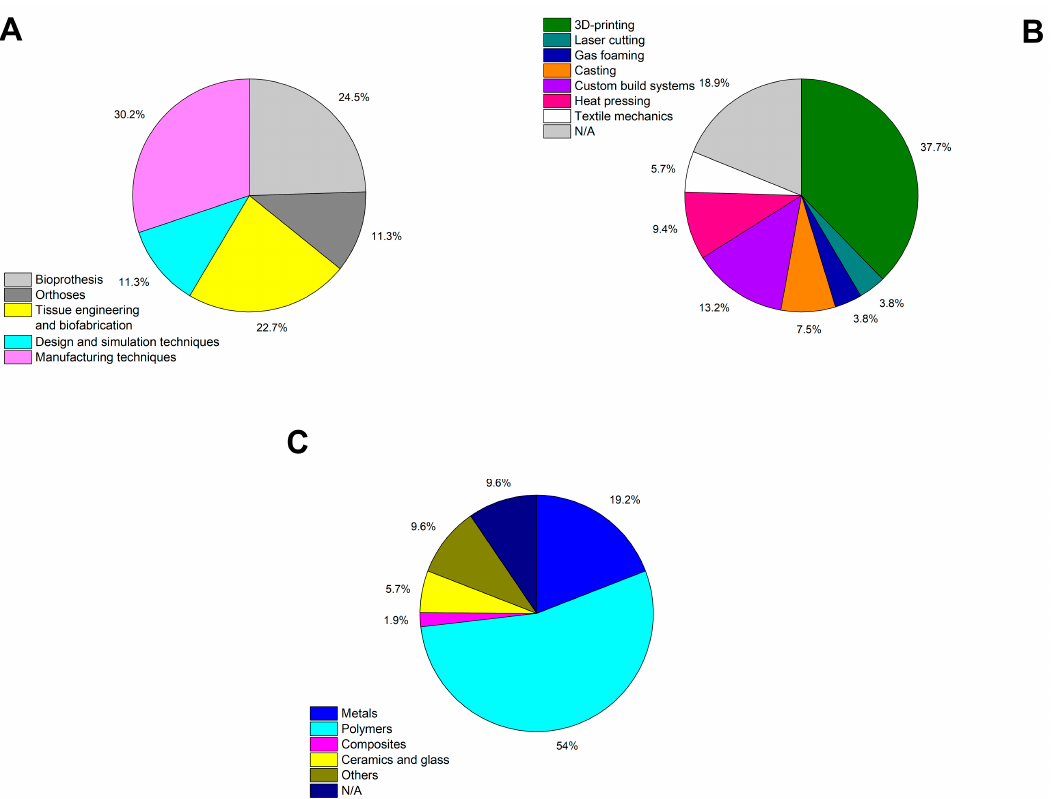
Figure 6. Summarizing statistics of the works reviewed in the current article: ( A ) by type of study; ( B ) by method of production; ( C ) by materials. The summary information for each examined paper can be found in Appendix A.